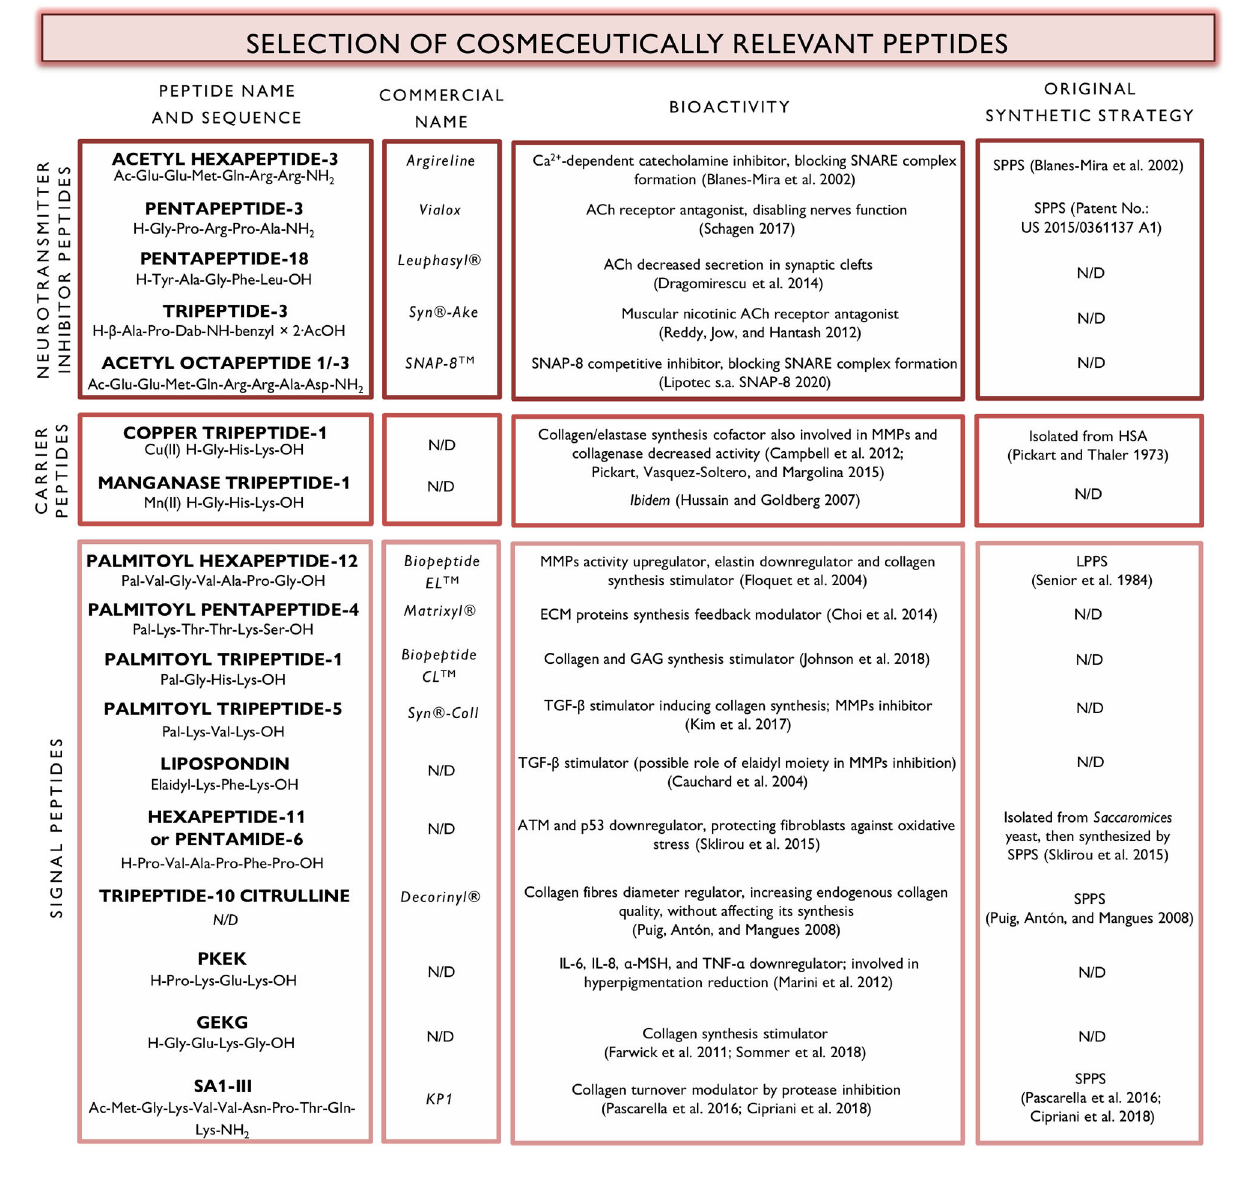
FIGURE 1 | Relevant peptides in commercially available